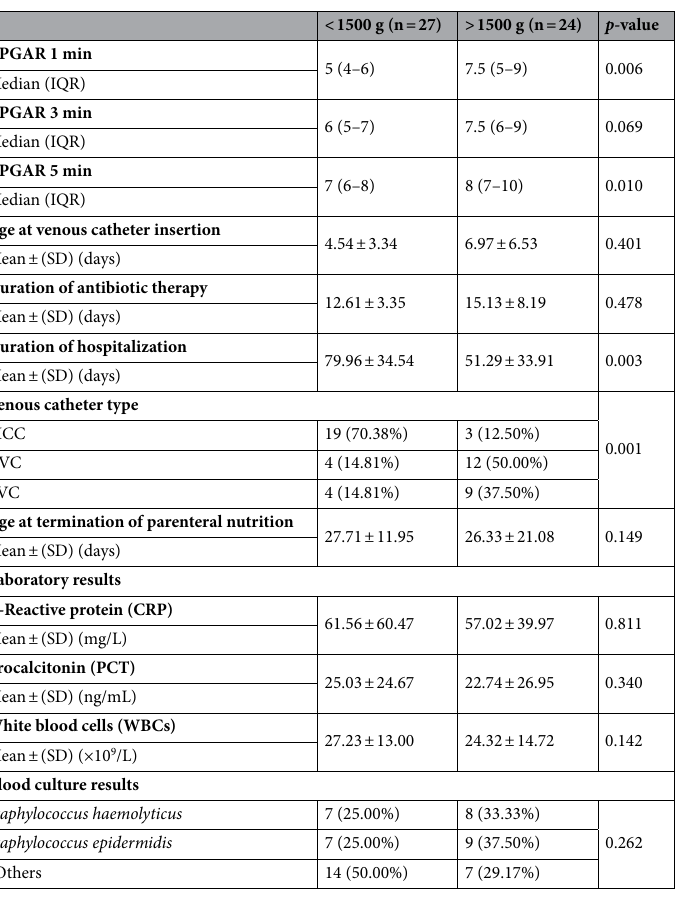
Table 2. Characteristics of assessed weight groups based on greater than or less than 1500 g in